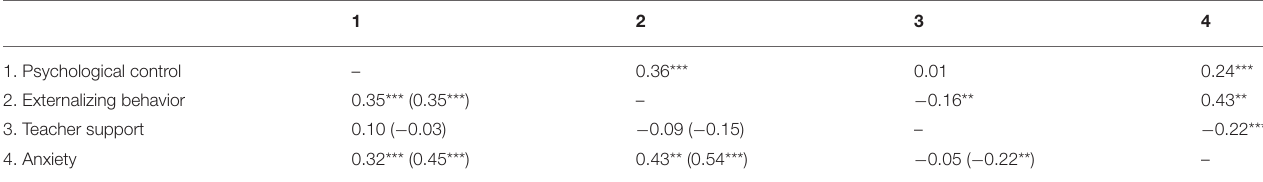
TABLE 2 | Correlations among variables separately for two-migrant-parent children, only-a migrant-father children, and accompanied